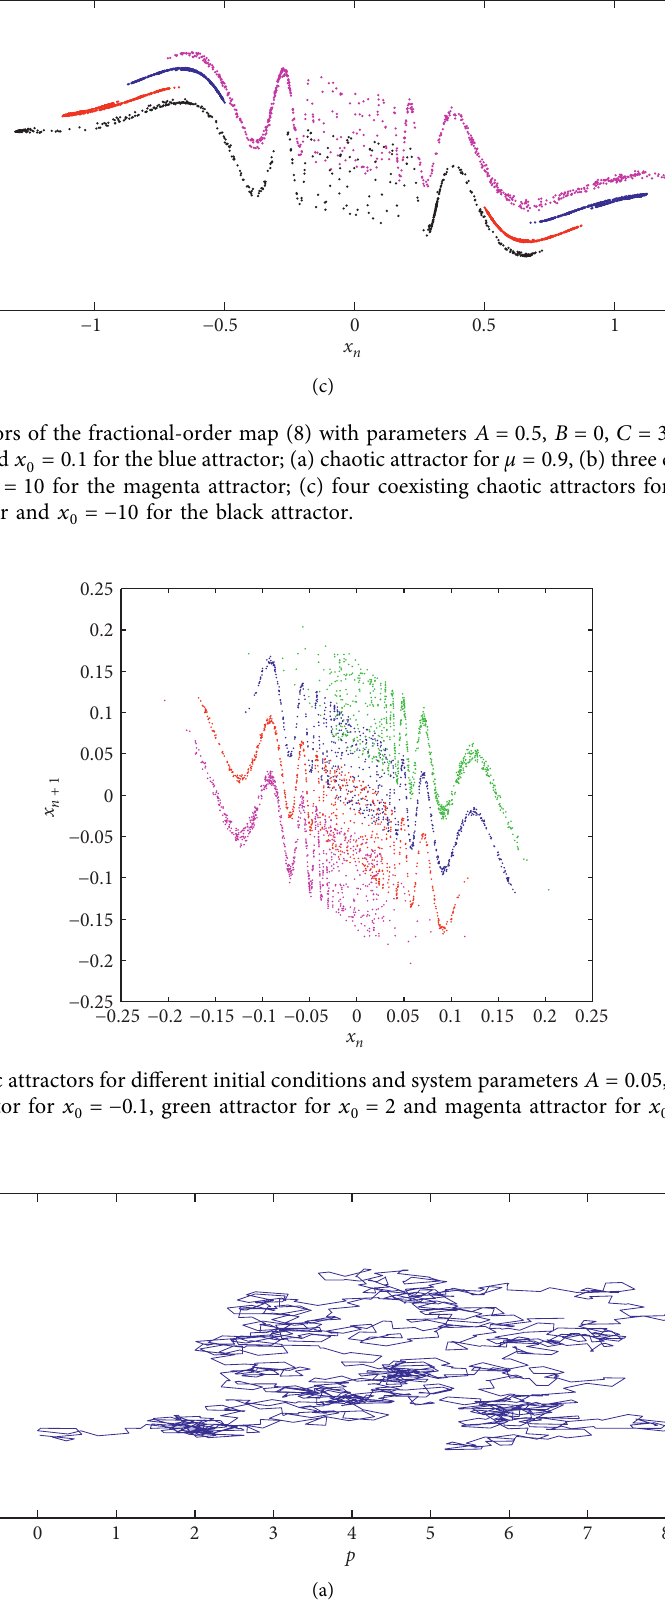
� 2 and magenta attractor for x 0